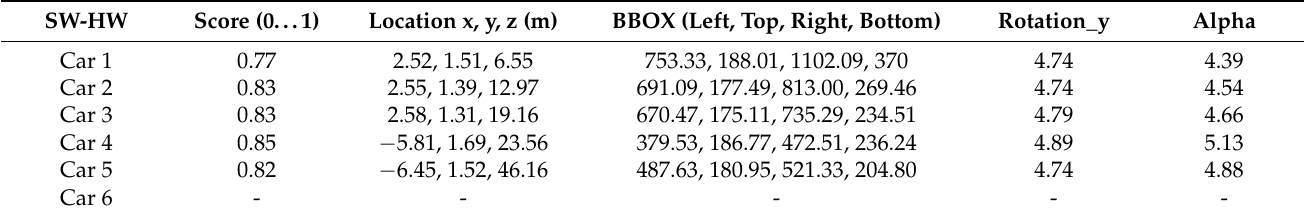
Table 3. Software–hardware model version metrics for the evaluated frame.